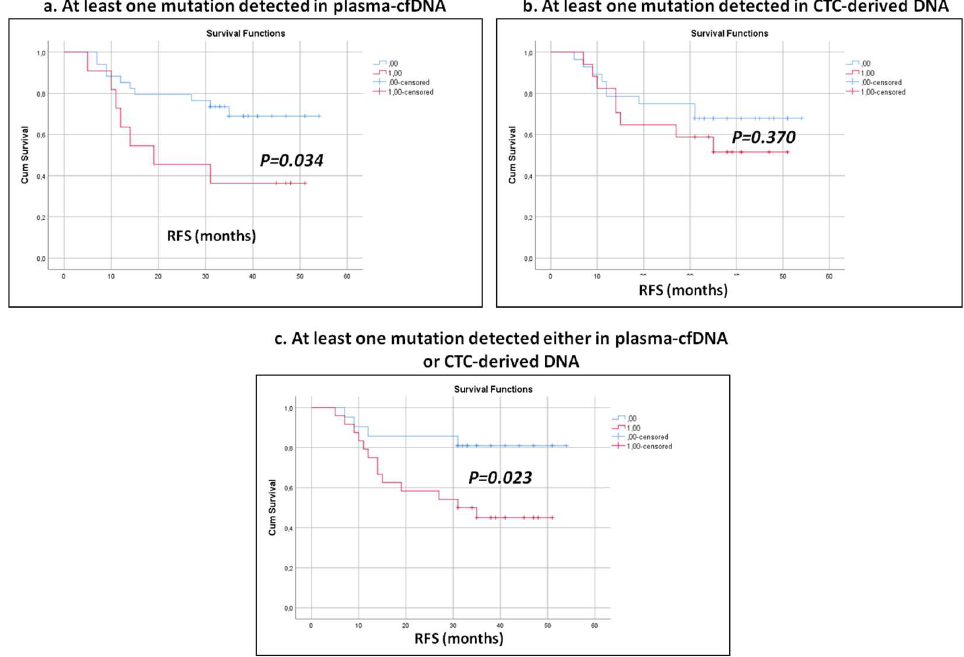
Figure 4. Kaplan–Meier estimates of recurrence-free survival (RFS) in months for early-stage NSCLC patients with respect to at least one mutation detected in ( a ) plasma-cfDNA, ( b ) CTC-derived DNA and ( c ) both liquid biopsy components.